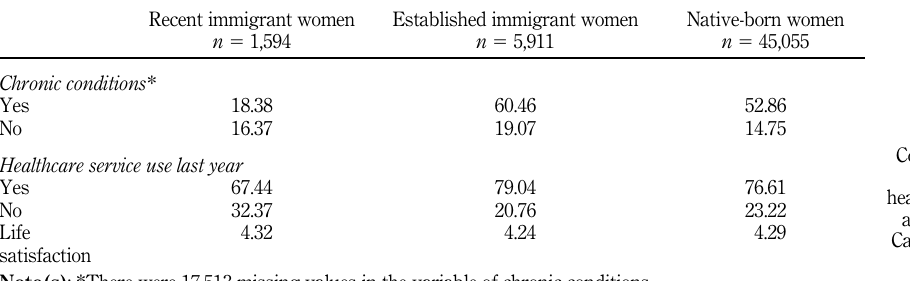
Table 2. Comparative general